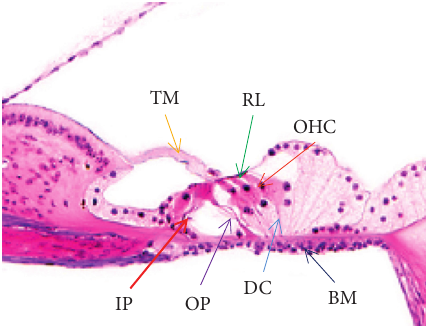
Figure 1: Cross-sectional anatomy of guinea pig [36]. IP, inner pillar cell; OP, outer pillar cell; DC, Deiters cell; BM, basilar membrane; OHCs, outer hair cells; RL, reticular lamina; TM, tectorial membrane.